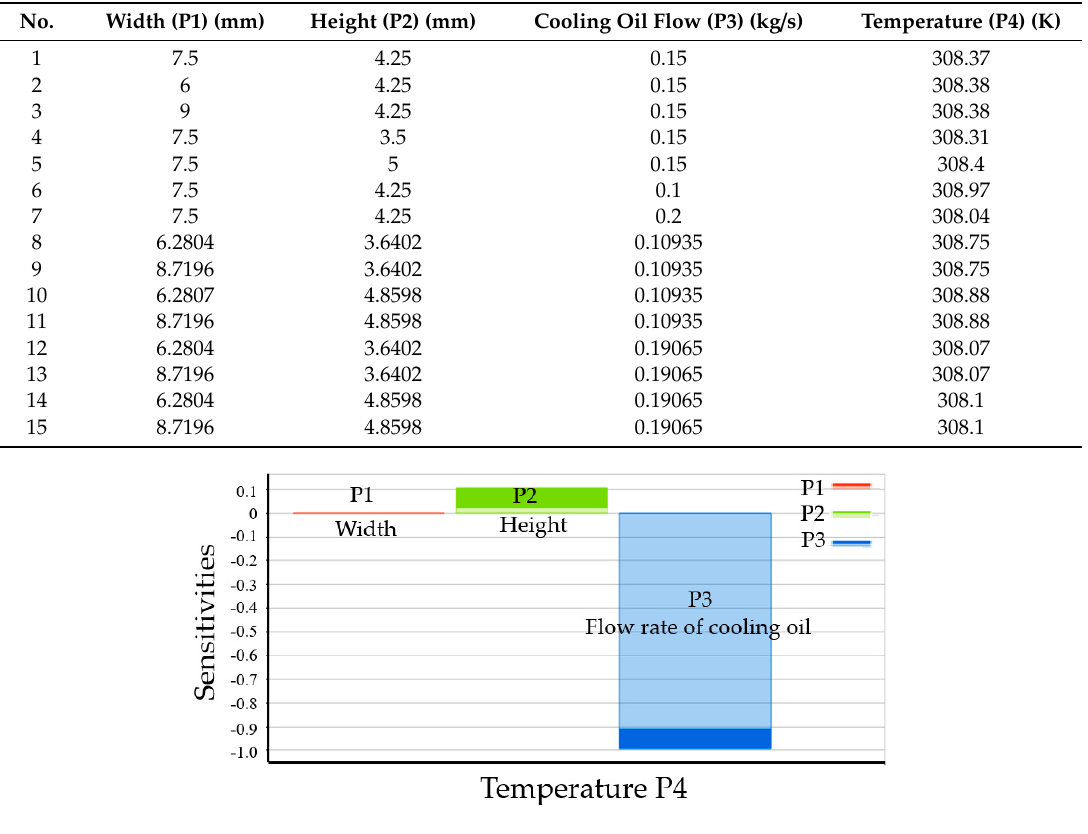
Table 5. Channel dimension optimization parameter list and results.